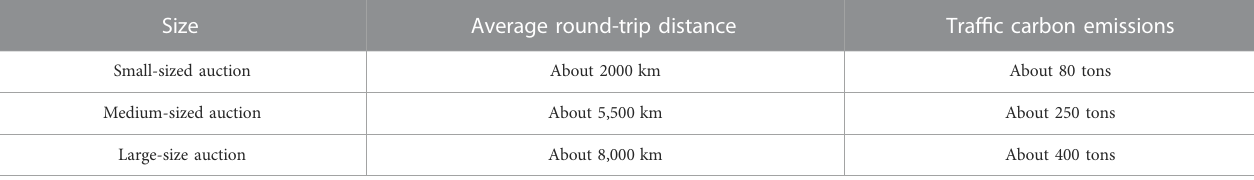
TABLE 3 Traf fi c carbon emissions from artwork auctions of different